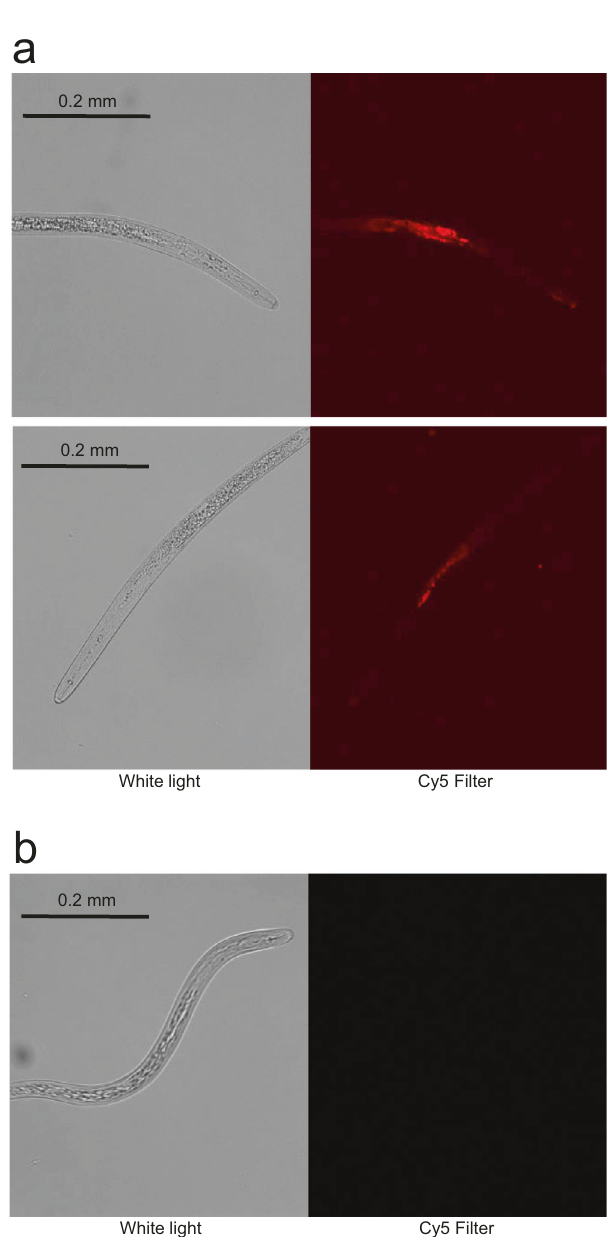
Fig. 7 Microscopic observation of ingestion of fl uorescently labeled Cry14Ab by Heterodera glycines . a Two second-stage juvenile H. glycines nematodes were fed IR680-labeled Cry14Ab at 1 mg/mL in the presence of the feeding stimulant octopamine for 24 h. Each nematode is shown under white light on the left, and with a Cy5 fi lter set on the right. The experiment was performed twice with 200 nematodes under each condition. About half ingested labeled protein, and three representative nematodes were photographed each time, of which two are shown here. b A nematode that was not fed labeled Cry14Ab, under white light on the left, and with a Cy5 fi lter set on the right. Source data are provided as a Source Data fi le.